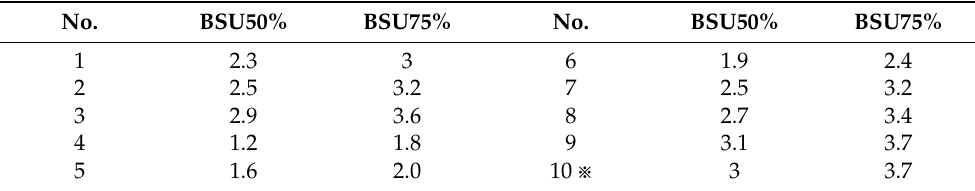
Table 2. BSU50% and BSU75% for a rotation speed of 1800 r/min.